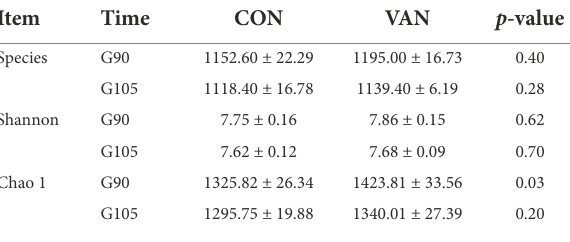
TABLE 4 The relative abundance of microflora (top 10) at phylum level between CON and VAN group (%).